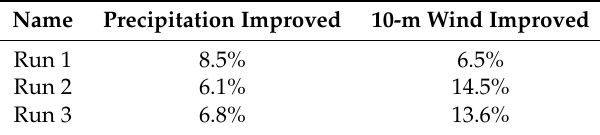
Table 4. Comparisons of the variable improvements for the two single objective optimization and the one dual objective